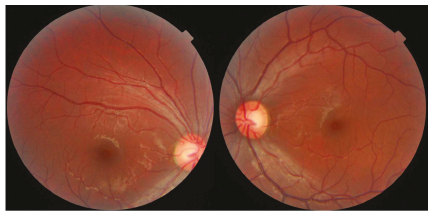
Figure 5: A 24-year-old male with bilateral decreased vision and detected mtDNA 11484 mutation. The fundus shows a pale bilateral disc and the thinning of the retinal nerve fi ber layer.